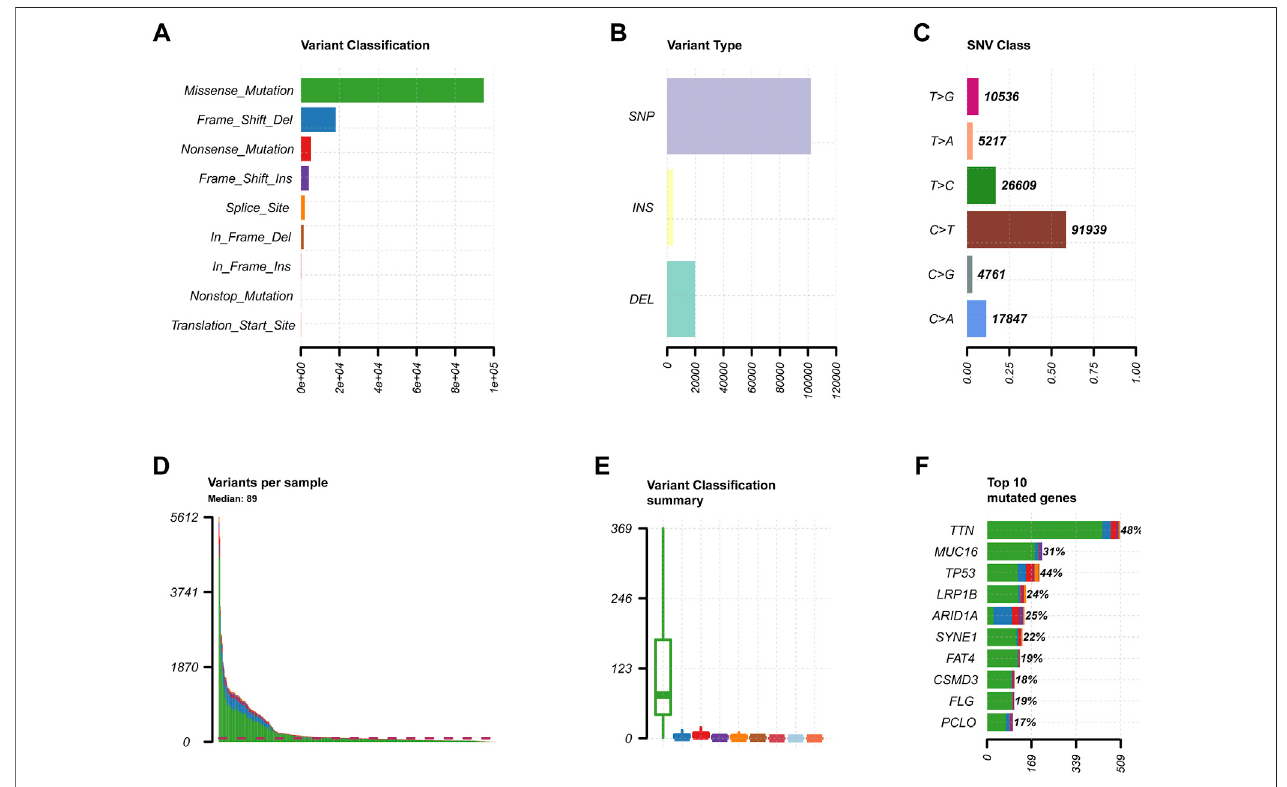
FIGURE1| PrimarygeneticchangesinSTAD. (A,B) GenevariantcategoriesinSTAD. (C) TheSNVclassi fi cationofSTAD. (D,E) TheSTADsamples ’ mutations. (F) STAD mutation pro fi le and fi rst 10 mutant genes.